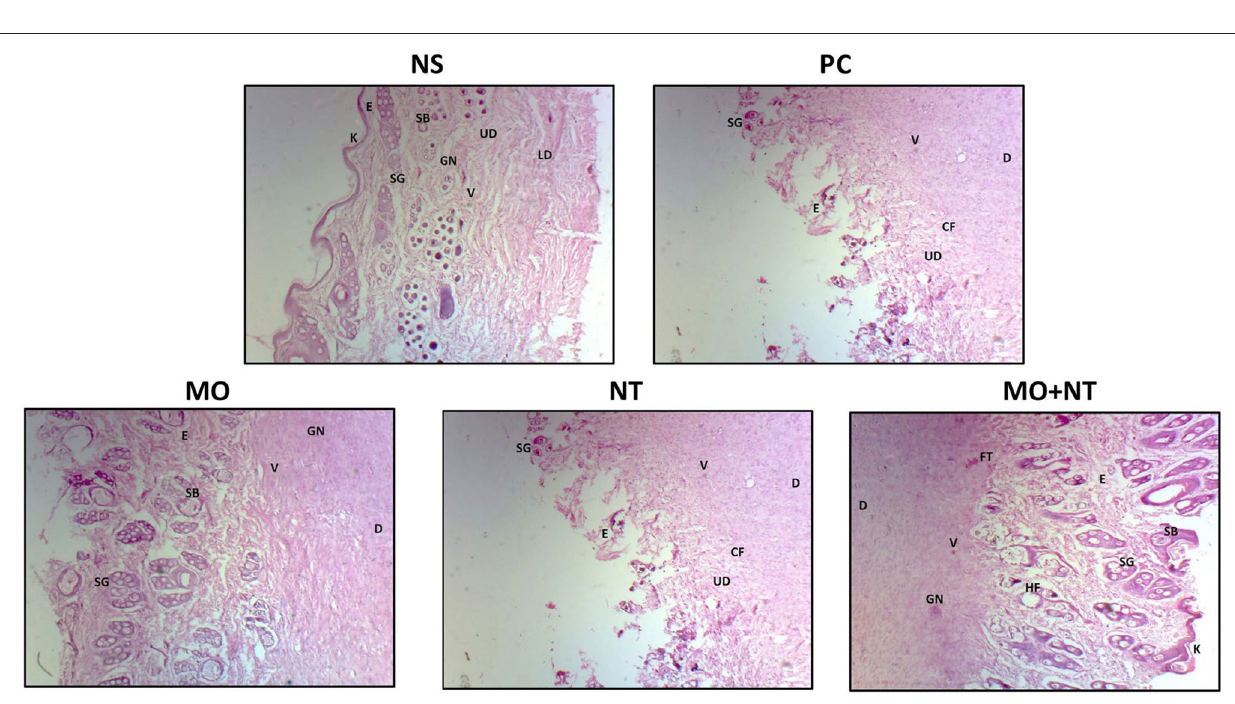
Frontiers in Veterinary Science |